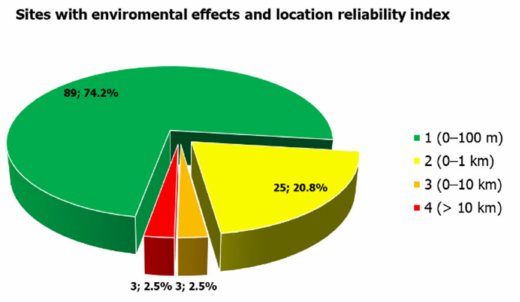
Figure 15. Pie chart showing the distribution of sites affected by the primary and secondary environ- mental effects triggered by the 12 August 1953 mainshock and its foreshocks on 9 and 11 August in the four classes of the location reliability